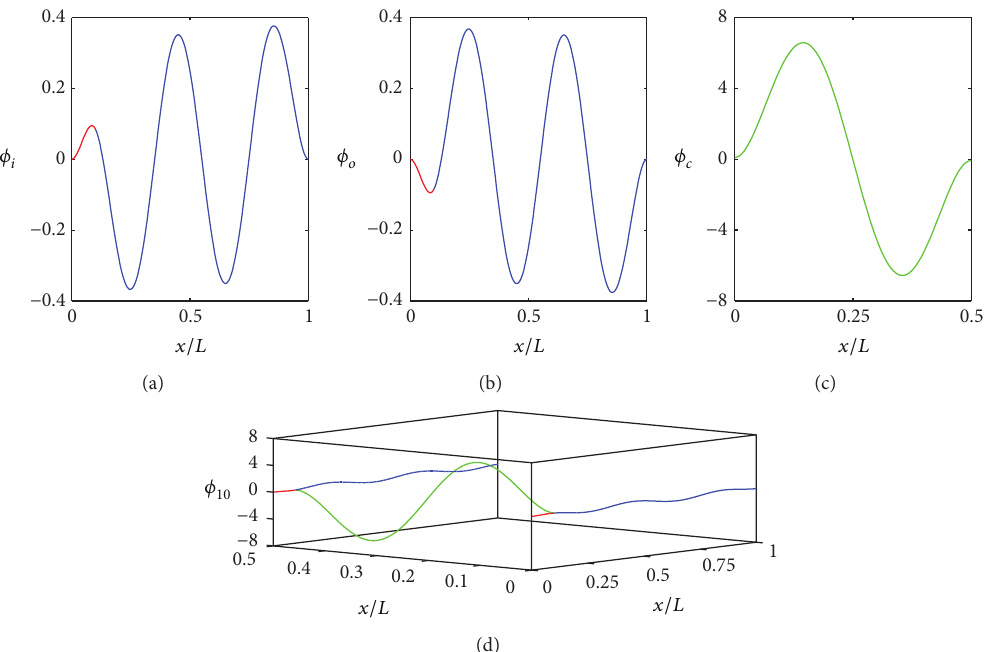
Figure 11: Tenth mode shape of the filter: (a) input, (b) output, (c) coupling beams, and (d) combination of (a), (b), and (c).